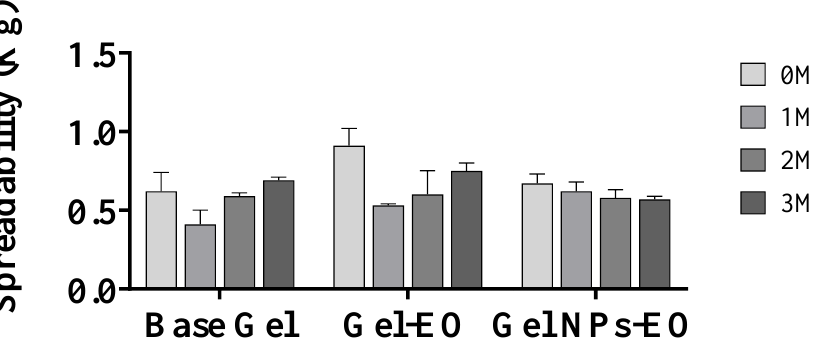
Figure 3. Spreadability analysis results of the prepared gel, i.e., Base Gel, gel containing free EO (Gel-EO) and gel with EO-loaded chitosan NPs (Gel NPs-EO), after preparation (0 M) and after 1, 2 and 3 months (M) of storage at 25 °C. Results are shown as the means ± SDs of 3 replicates.